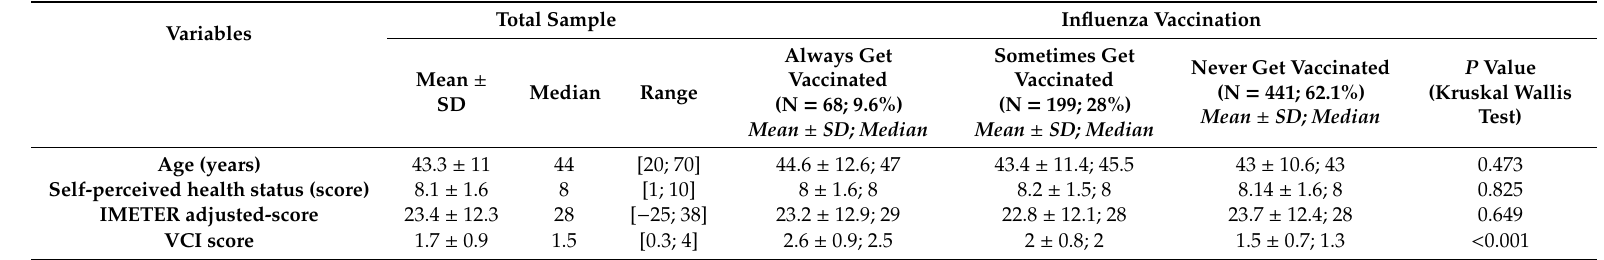
Table 3. Characteristics (numerical variables) of the sta ff (N = 711): total sample and by reported influenza vaccination uptake in 2016–2017, 2017–2018 seasons and intention to vaccinate in